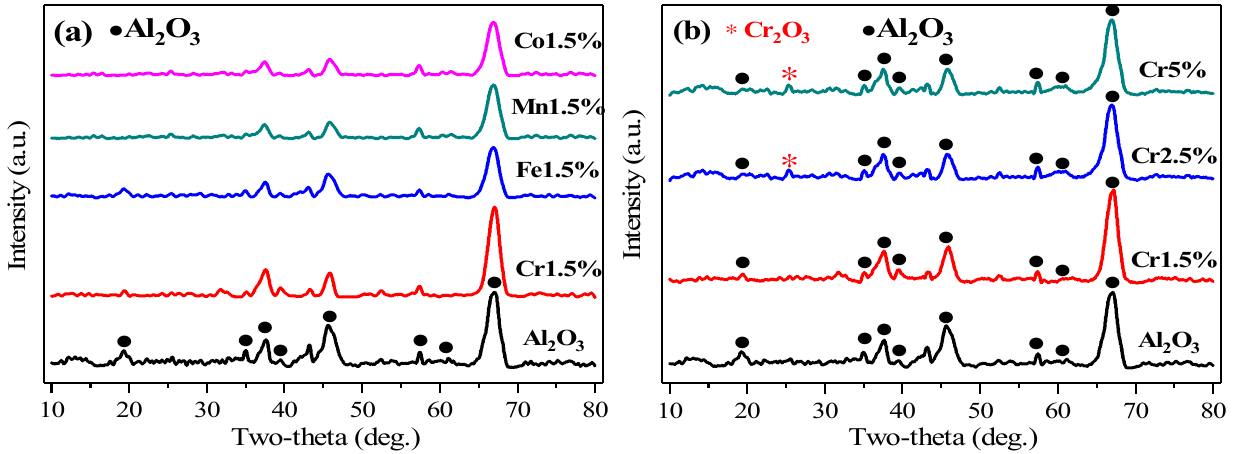
Figure 2. XRD patterns of different catalysts. ( a ) γ -Al 2 O 3 , MO x / γ -Al 2 O 3 (M = Cr/Fe/Mn/Co); ( b ) γ -Al 2 O 3 , Cr1.5~5%. Table 2. Crystallite phases and sizes of Al 2 O 3 in catalysts.